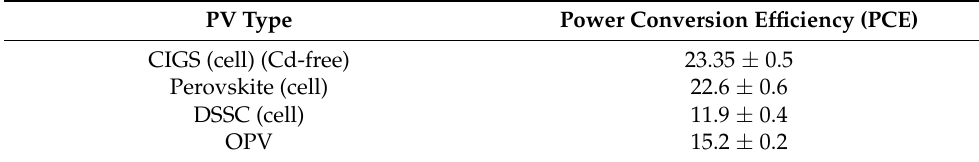
Table 1. Power conversion efficiency under global AM1.5 spectrum (1000 W/m 2 ) at 25 ◦